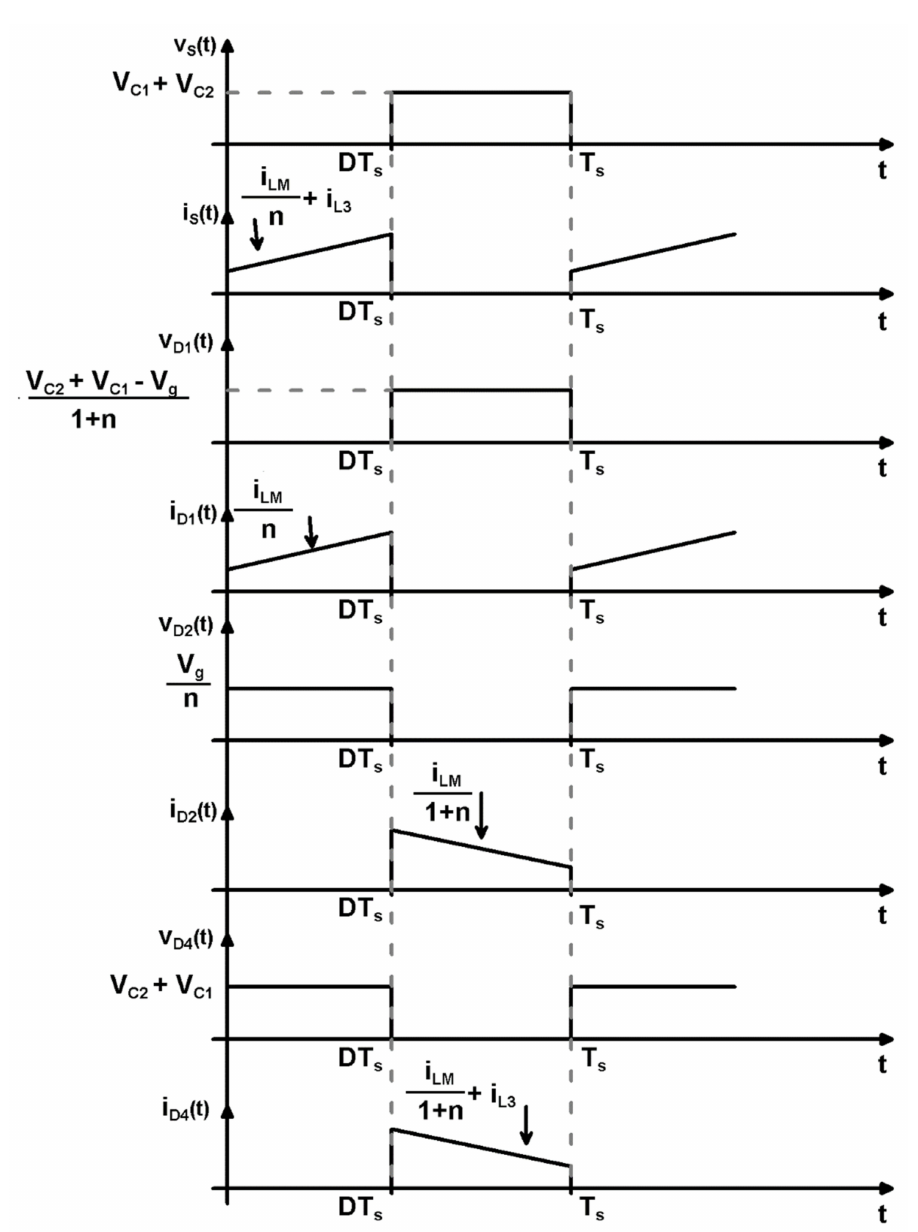
Figure 6. Main waveforms associated to the semiconductor devices. The magnetizing inductor voltage v LM is piecewise constant, exhibiting a rectangular shape, while the magnetizing inductor current i LM is piecewise linear, increasing until D · T s , because v LM is positive in the first topological state and decreasing in the second topological state, when the voltage is negative. Similarly, the same theoretical waveforms are associated for inductor voltage v L 3 and inductor current i L 3 . Internal capacitor current i C 1 and output capacitor current i C 2 are piecewise constant, resulting in a piecewise linear internal capacitor voltage, v C 1, and output capacitor voltage, v C 2 . The semiconductor waveforms, depicted in Figure 6, result from taking into account that, when “ ON ”, the semiconductor currents are linear combinations of inductor currents and the same is true for semiconductor voltages. These linear combinations values are also specified in Figure